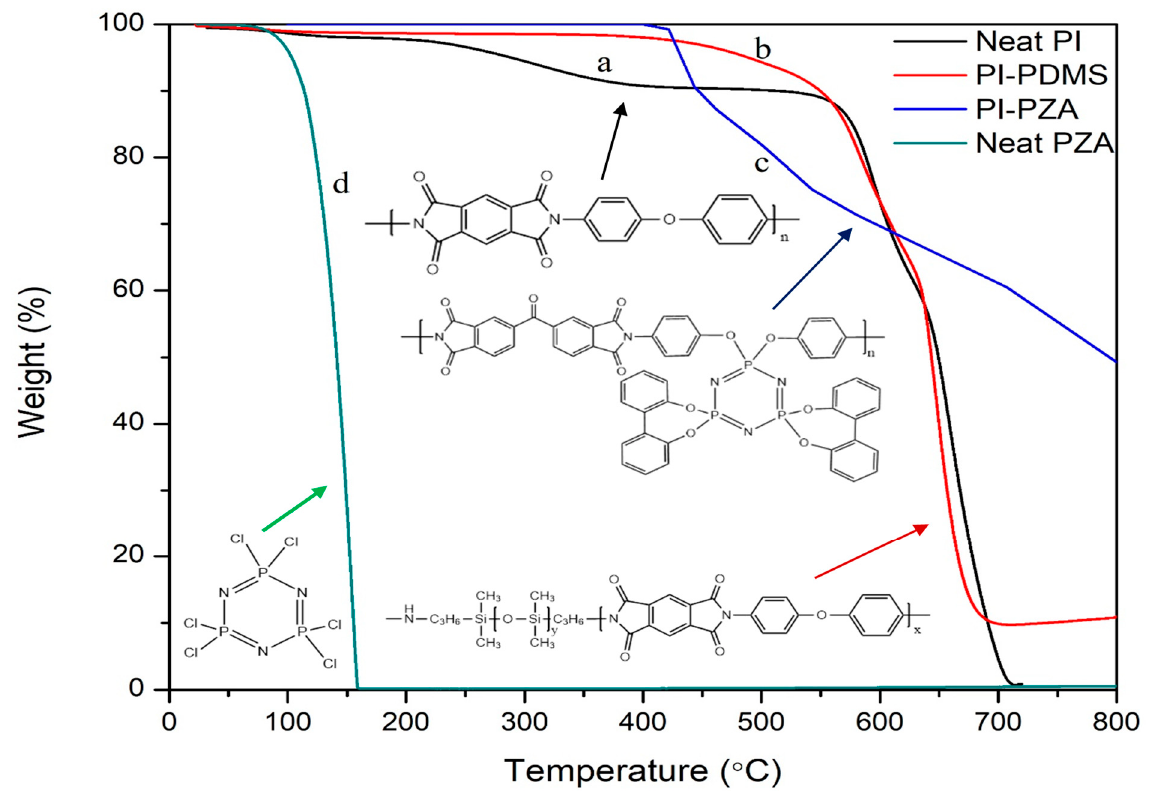
Scheme 4. Schematic representation of the synthesis of polyimide copolymer containing amine- functionalized phosphazene [136].